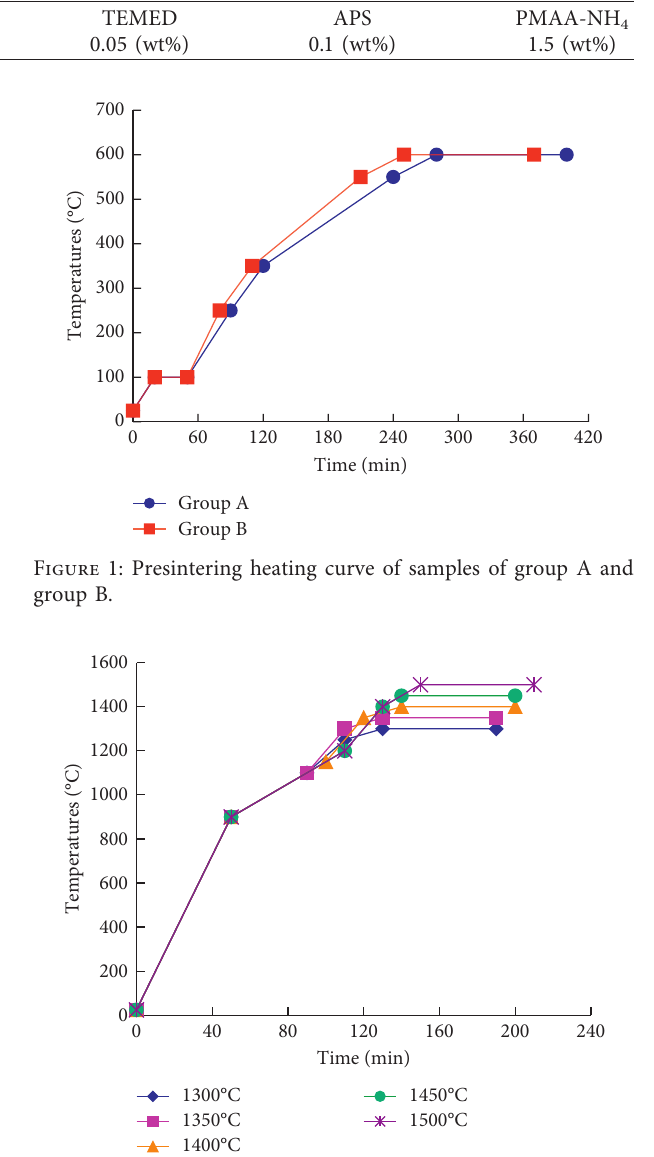
Figure 2: Sample heating rate at different sintering